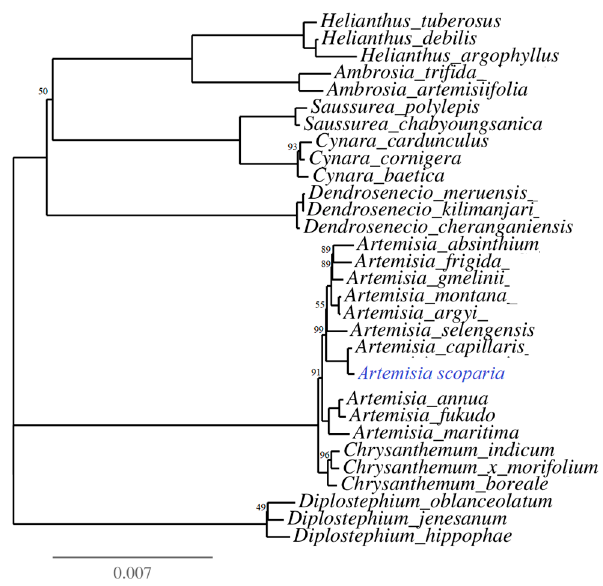
Figure 4. Phylogenetic relationships among 30 species of the family Asteraceae. The number on each node represents the bootstrapping value. The bootstrapping values equal to 100 were not represented on the nodes and omitted from the tree for quality visualization.